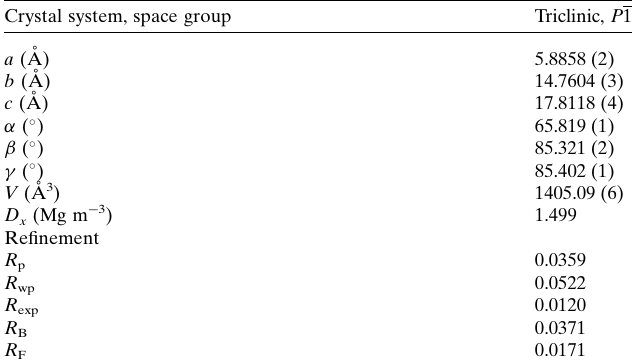
Table 3 Experimental data of the X-ray powder diffraction study performed at 293 K.